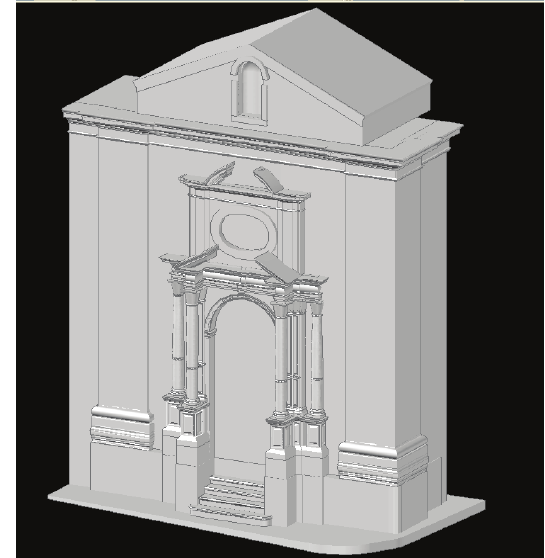
Figure 12. Rendering of Anime Sante’s church geometric model